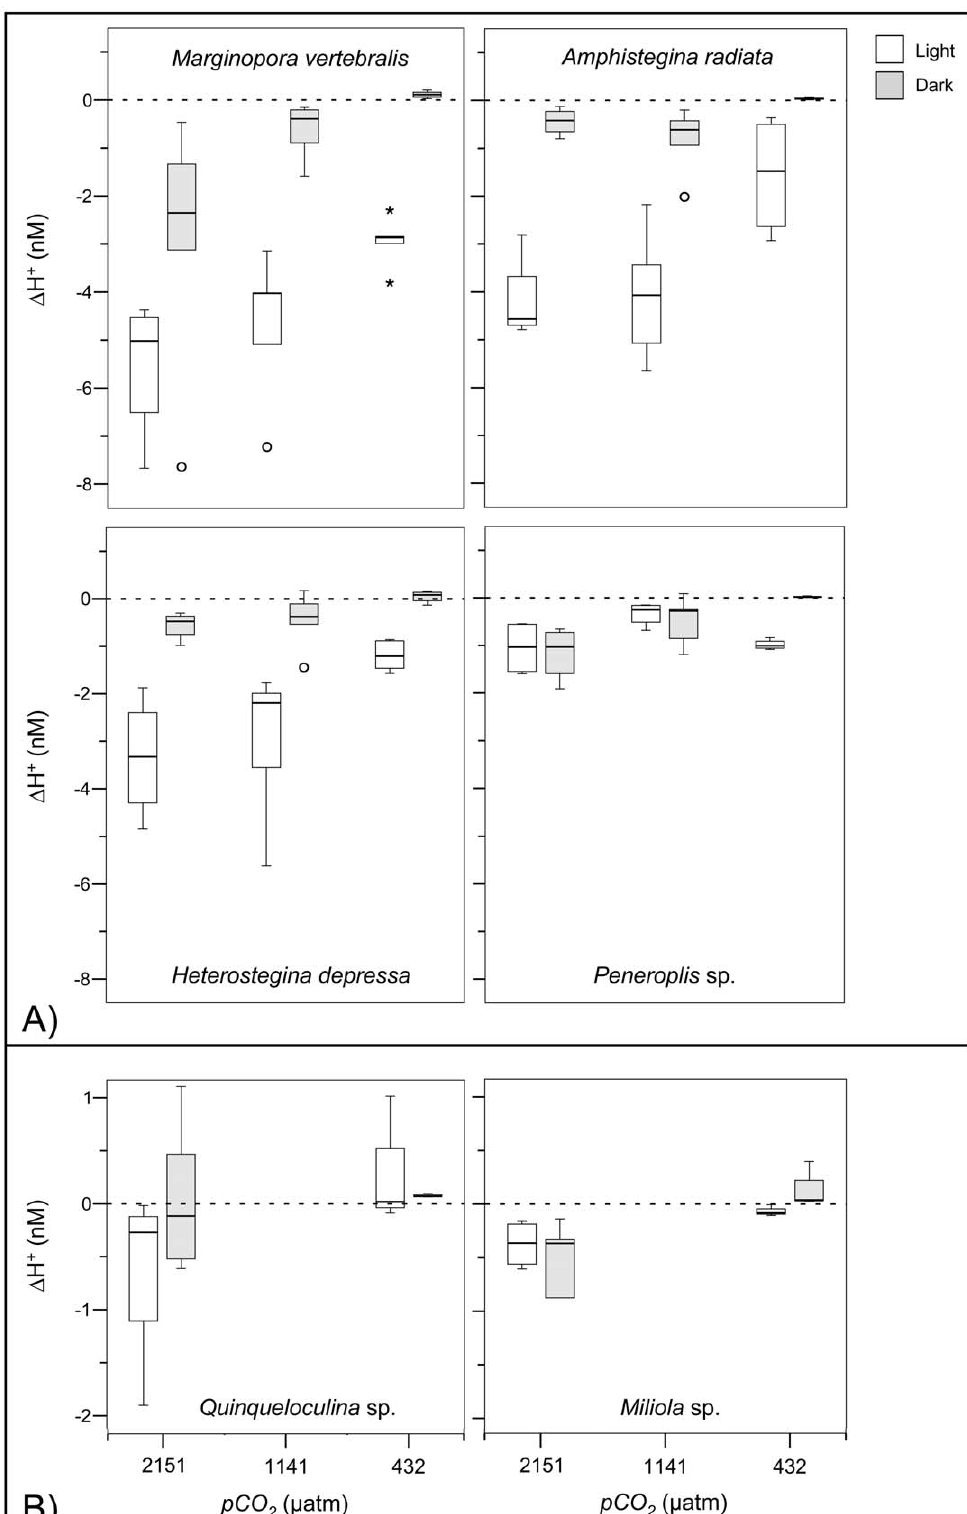
Figure 6. Box-plots representing the 25 th , 50 th and 75 th percentiles of D H + , calculated from profiles measured during the pCO 2 treatment incubation, at light (30 m mol photons m 2 2 s 2 1 ) and dark conditions for individual species. Note the different scales between A) photosymbiotic and B) symbiont-free species. Outliers ( . 1.5 interquartile range) and extreme values ( . 3 times interquartile range) are indicated by (O) and (*) respectively.